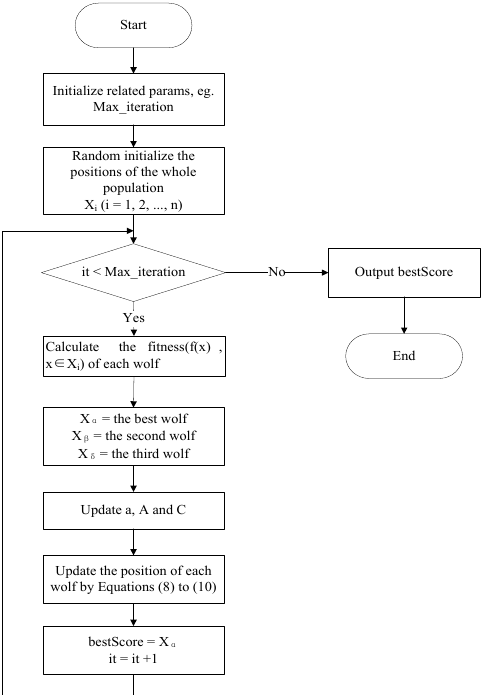
Figure 1. The complete flow chart of